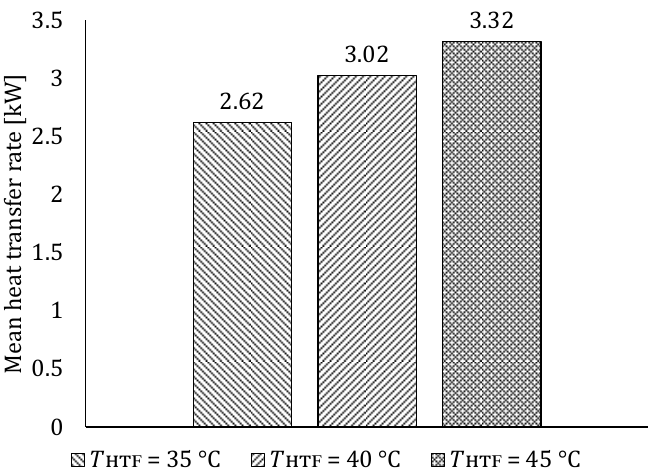
Figure 15. Comparison of mean heat transfer rates during melting obtained numerically for different HTF temperatures, HTF inlet flow rate 800 l/h and initial PCM temperature 15 °C.